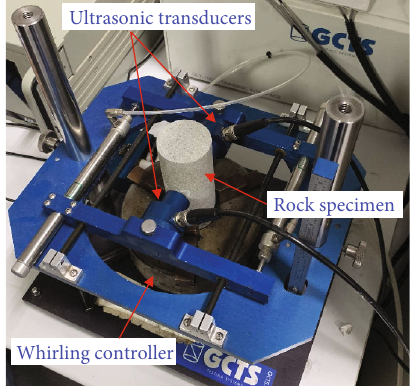
Figure 3: CVA-100 wave velocity anisotropy testing